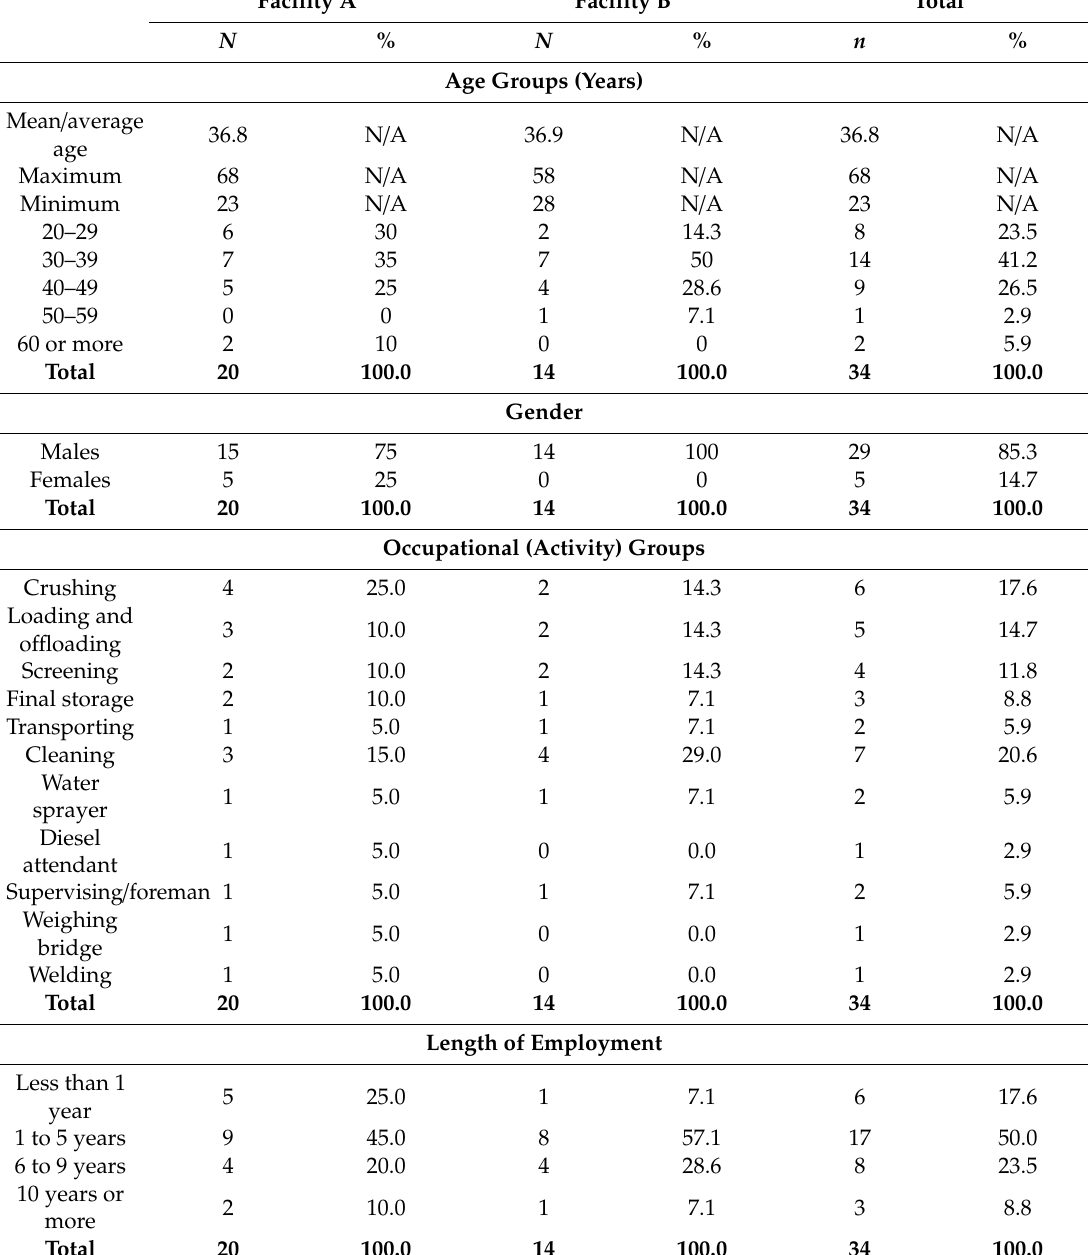
Table 1. Distribution of platinum mine workers’ demographic and occupational characteristics by